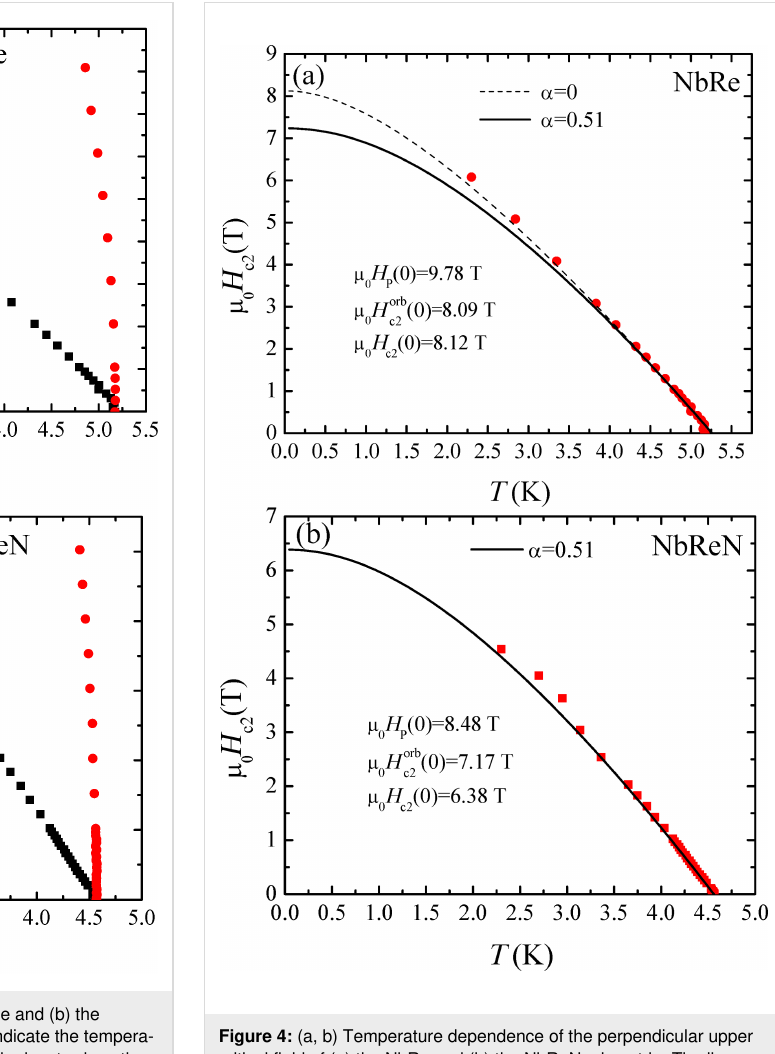
Figure 4: (a, b) Temperature dependence of the perpendicular upper critical field of (a) the NbRe and (b) the NbReN microstrip. The lines represent the WHH calculations. Details of the procedure are given in the text.